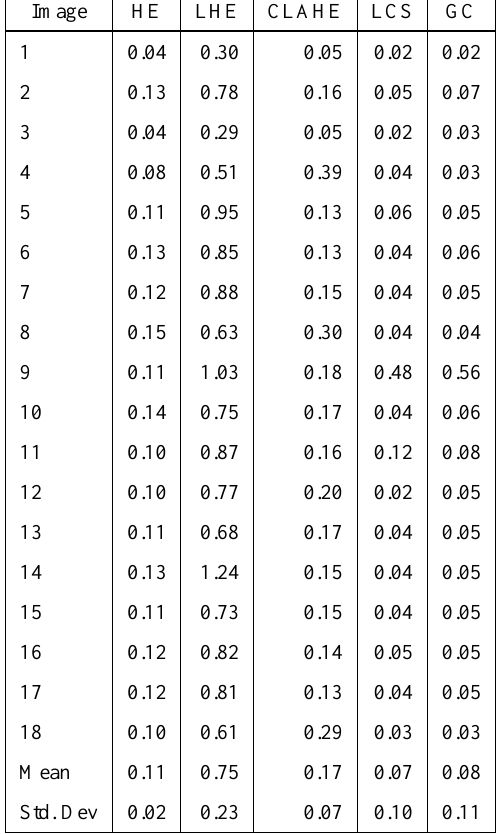
Table 7: Time required (seconds/megabytes) by each enhancement algorithm (columns) to process the 18 false